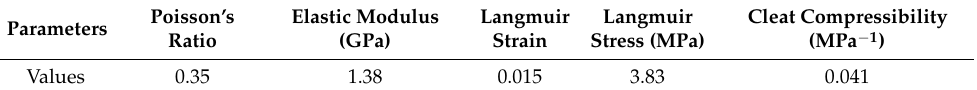
Table 4. Mechanical properties and swelling parameters obtained from Robertson (2005) [35].